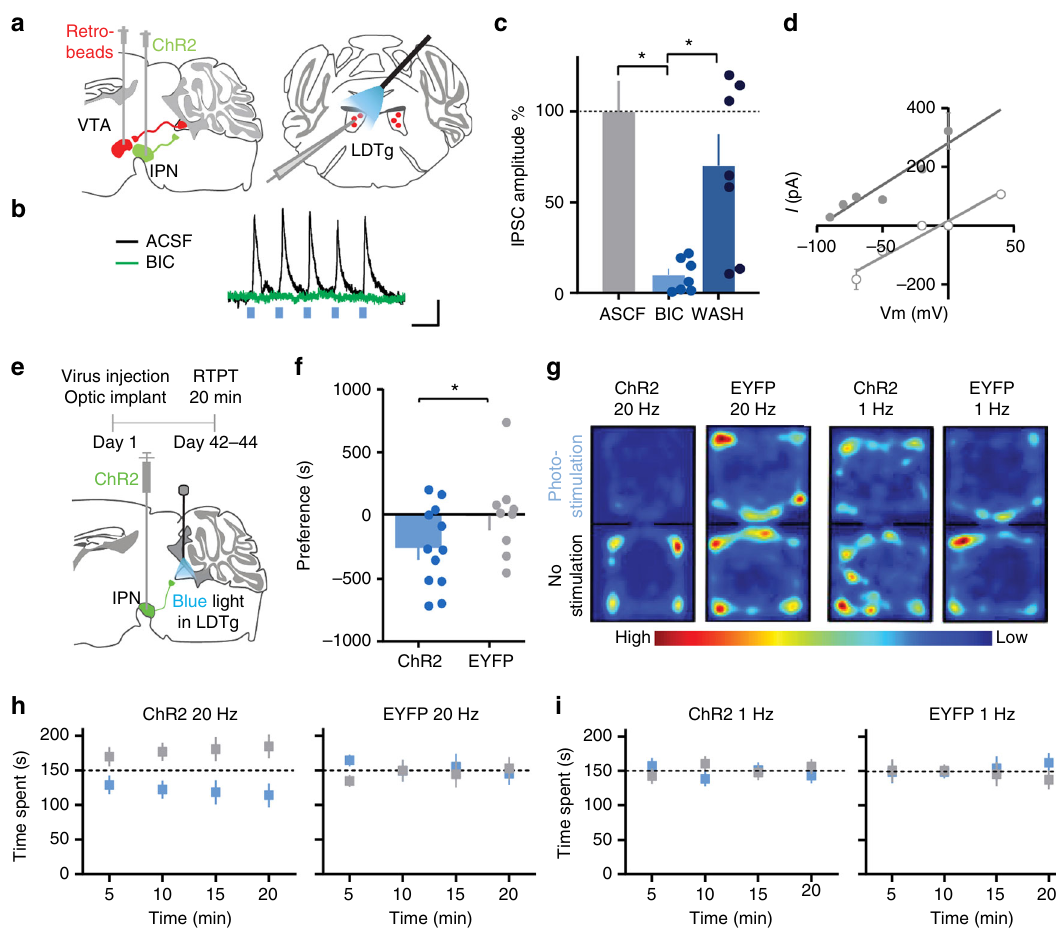
Fig. 2 IPN inputs to LDTg are GABAergic and mediate aversion. a Left: schematic of viral and dye injections. Right: schematic of recording set-up. b Representative light-evoked synaptic currents before and during bicuculline (100 ms, 20 pA scale). c Normalized light-evoked synaptic current amplitudes before, during, and after bicuculline application (20 μ M); one-way RM ANOVA, F 1.147, 6.882 = 7.863, P = 0.0246; Tukey: P = 0.0188, P = 0.0321, n = 7 cells from 5 mice. d Current – voltage relationship, (grey circle) E = − 125 mV, (white circle) : E = − 17 mV. (linear regression, 95%CI: Cl Cl − 144.6 to − 78.51; 95%CI: − 23.78 to 16.94; slopes: P = 0.4098; reversals: − 98.30 mV and − 6.671 mV, adjusted for junction potential: − 114.2 mV and − 16mV; n = 2 cells per condition from 2 mice). e Behavioral experiment timeline and schematic. f RTPT preference scores for 20 Hz stimulation; unpaired t -test (one-tailed), t = 1.774, P = 0.0460, n = 12, n = 9 mice per group. g Representative heat maps of animal positions (20 Hz and 1 Hz stimulation). 19 h Time spent on photo-stimulation side (blue box) and no-stimulation side (grey box) with 20 Hz stimulation. i Same as h but with 1 Hz stimulation. Data presented as mean ± SEM, * P <